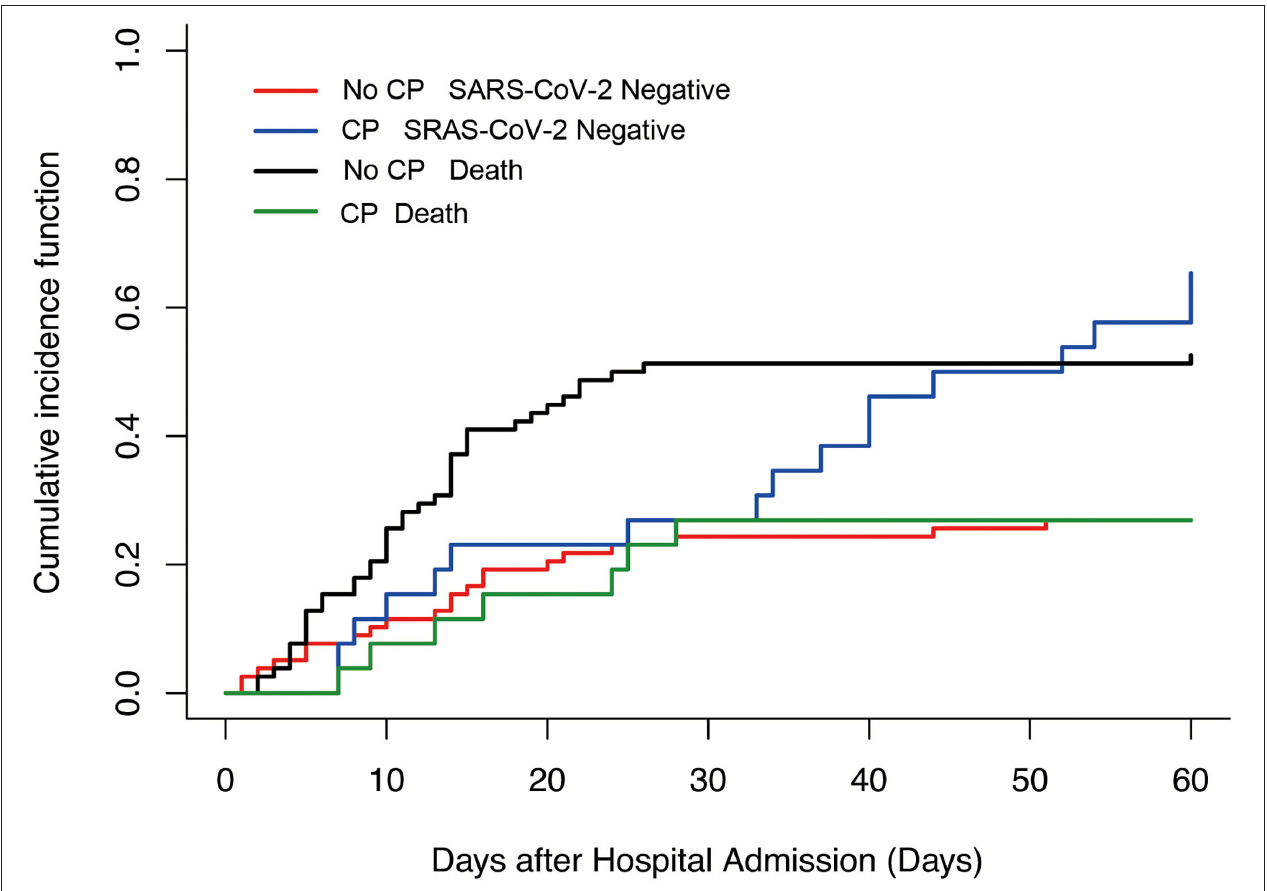
FIGURE 3 | Competing risk analysis to explore Convalescent plasma therapy associated with events of interest in severe and life-threatening coronavirus disease 2019 (COVID-19). No CP SARS-CoV-2 negative vs. CP SARS-CoV-2 negative, p = 0.002; No CP death vs. CP death, p = 0.02. CP, convalescent plasma